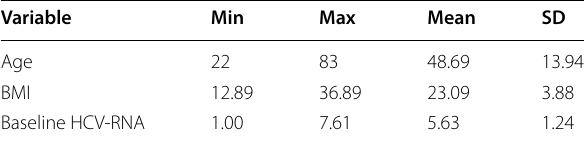
Table 2 Descriptive values of age, BMI, and baseline HCV-RNA